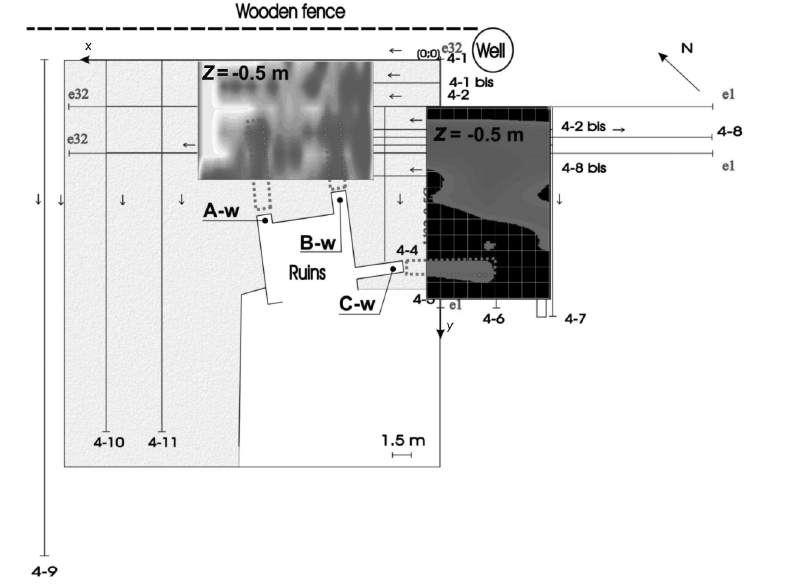
Fig. 6. Overlap between two 0.5 m depth 3D GPR model slices and the site